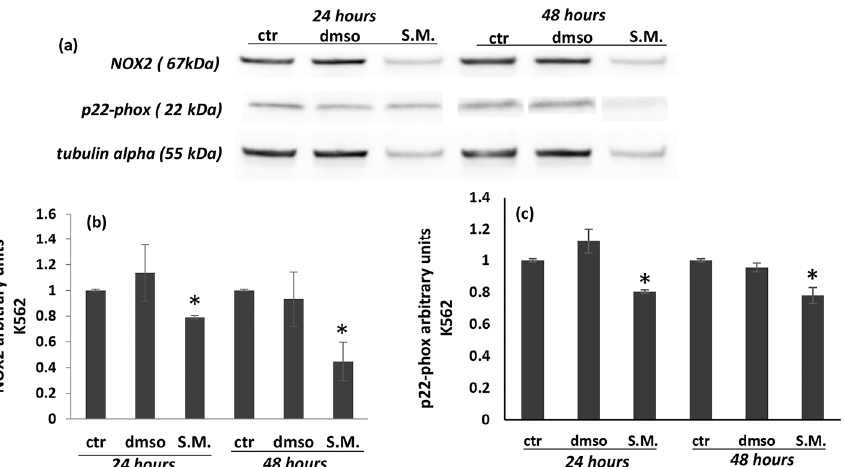
Figure 8. Effect of Skeletonema marinoi (S.M.) on NOX2 and p22-phox protein levels in K562 cells after 24 and 48 h of treatment. Panel ( a ): representative Western blot of NOX2 and p22-phox in K562 cells; panel ( b ): densitometric analysis of NOX2; panel ( c ): densitometric analysis of p22-phox. Experiments were conducted in triplicates, and the values were normalized towards tubulin. Densitometric analyses were expressed as arbitrary units. Data are shown as mean ± standard deviation (SD) and were compared by ANOVA (* p < 0.05 versus untreated K562 cells).